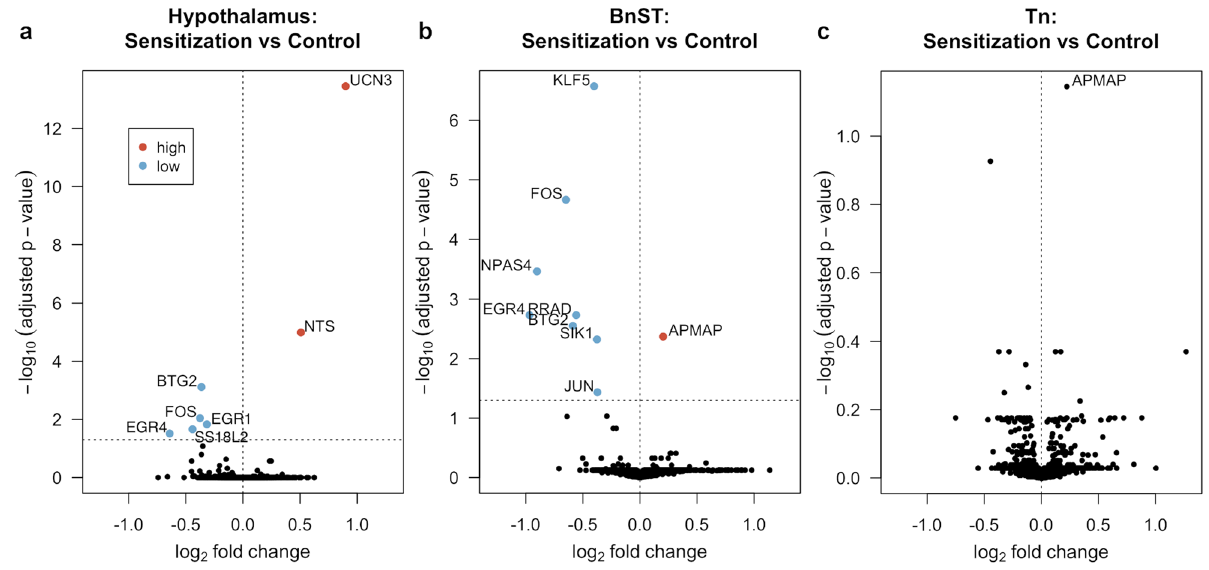
Figure 2. Volcano plots representing the log 2 fold change against the corresponding – log 10 p adj -value of all genes for each of the three brain regions studied: ( a ) hypothalamus, ( b ) BnSt, ( c ) Tn. Differentially expressed genes (p adj < 0.05) are shown in red if they are up-regulated in the sensitization treated animals relative to control and in blue if they are down-regulated. Other genes are shown in black. The horizontal dotted line indicates the p adj -value cut-off, while the vertical dotted line marks the point for zero fold change differences. One down- regulated gene without annotation is not show for hypothalamus (see Supplementary Table S2 for complete list).